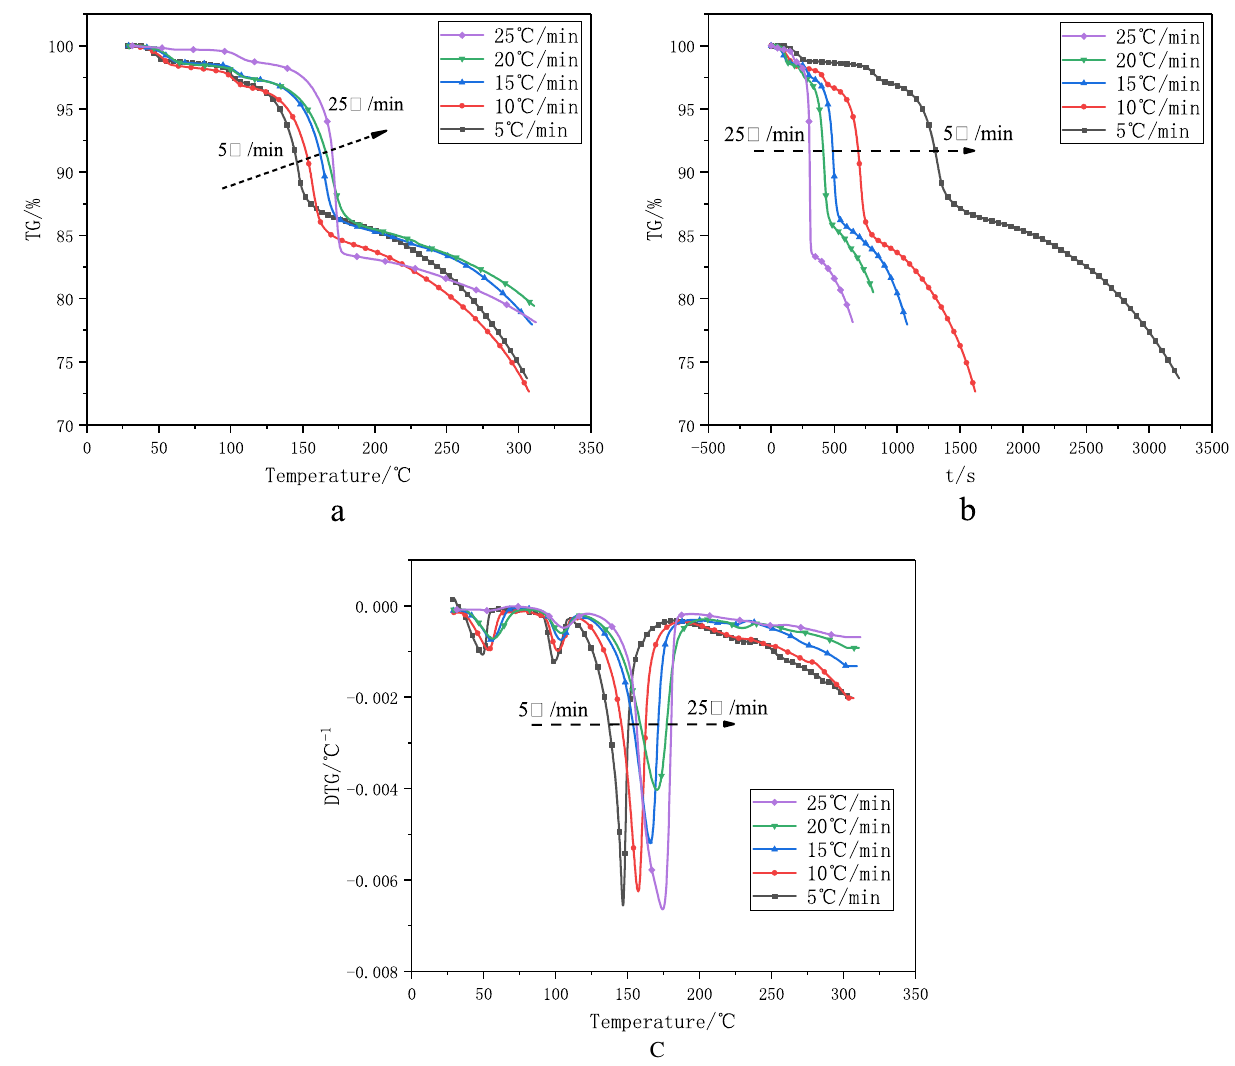
C Figure 4. TGA -temperature diagram ( a ) 、 TGA-time diagram ( b ) and DTG- temperature diagram ( c ) of 1-nitroso-2-naphthol at different heating rates.